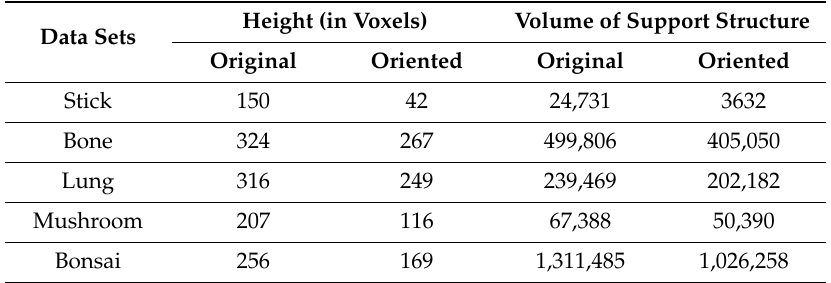
Table 1. Heights and volumes of support structures of the test data (measured in